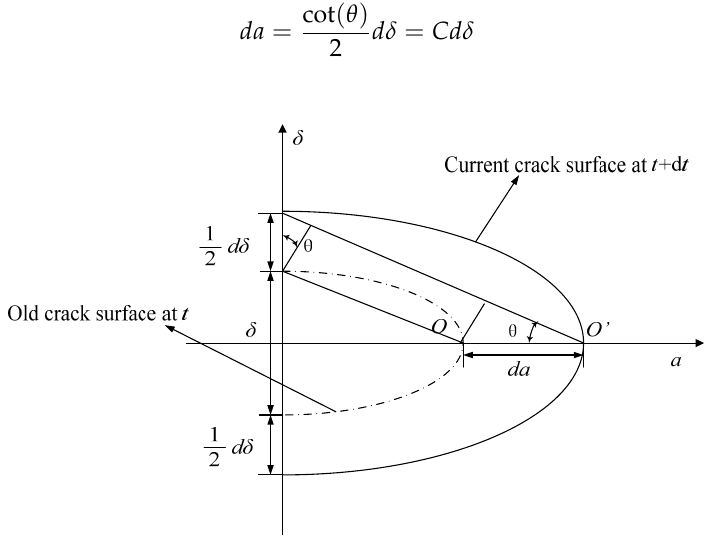
Figure 2. Schematic representation of crack tip geometry profiles during fatigue crack growth.